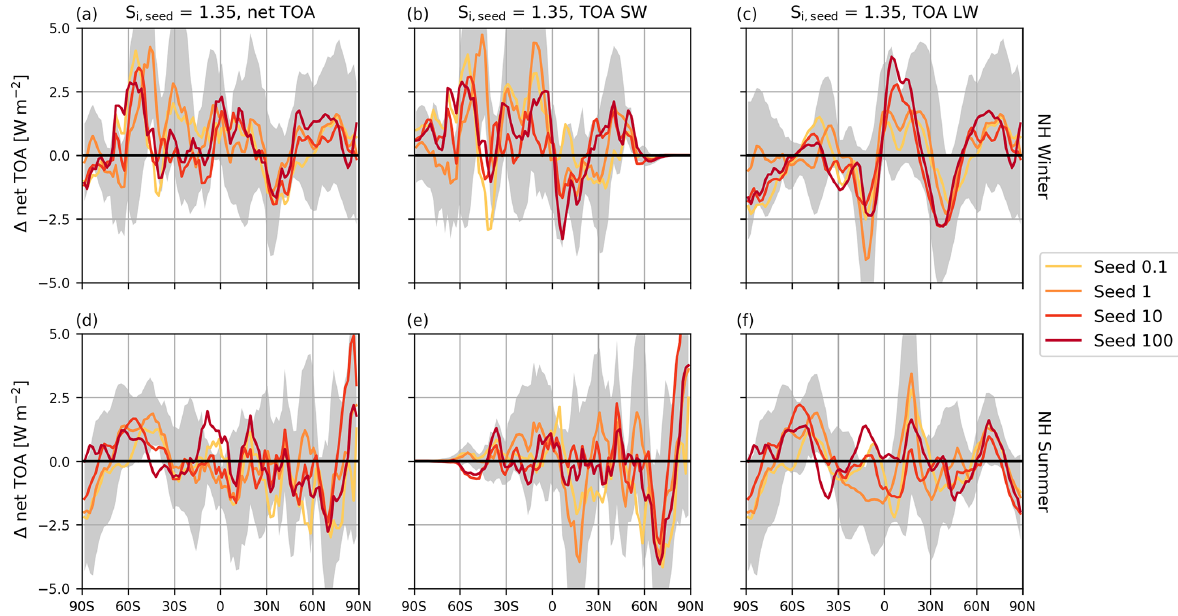
Figure 11. The 1.35 seeding zonal mean radiative balance anomalies in Wm − 2 for all seeding particle concentrations for the net TOA (a, d) , TOA SW (b, e) , and TOA LW (c, f) . The top row shows the 4-year zonal mean for NH winter (December–February) and the bottom row is the 5-year zonal mean for NH summer (June–August). The grey-shaded area is the 95% confidence interval around the mean Seed1 anomaly, representing the 2 times standard deviation interval, based on the variance of the annual